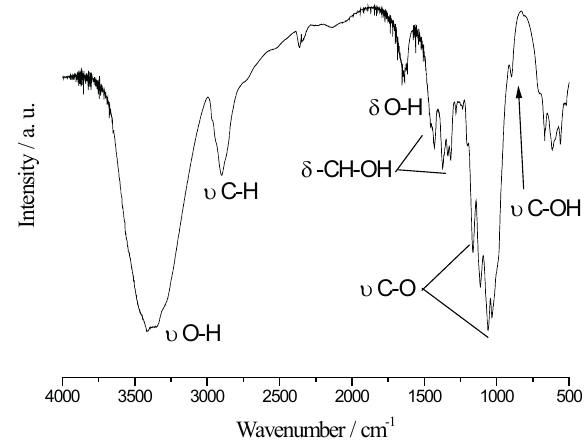
Figure 2: Fourier Transform Infrared spectrum of celulose.